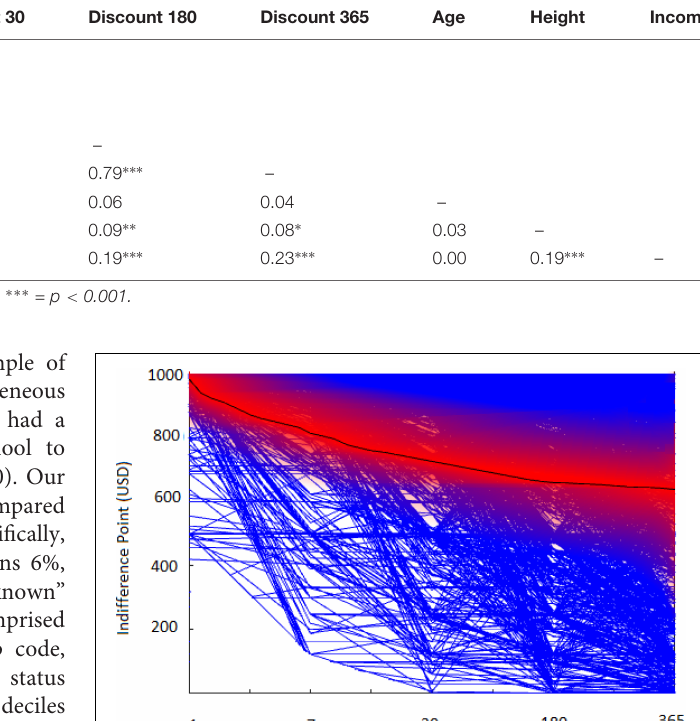
Frontiers in Psychology |